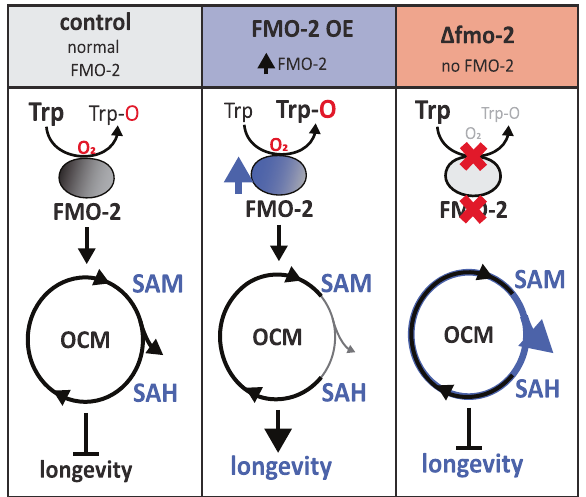
Fig. 6 | Proposedmodel. Incontrolconditions, thereisverylow fmo-2 expression, leading to low levels of tryptophan metabolism/kynurenine production through FMO-2, and maintaining normal fl ux through one carbon metabolism and normal lifespan. When fmo-2 is induced, FMO-2 oxygenates tryptophan, leading to increased kynurenine production and decreased methylation output fl ux through OCM,therebyextendingnematodelifespan.When fmo-2 isabsent,thesemetabolic changesdonotoccur,preventinganextensioninlifespan.Thegraylinerepresents decreased fl ux and the blue line represents increased fl